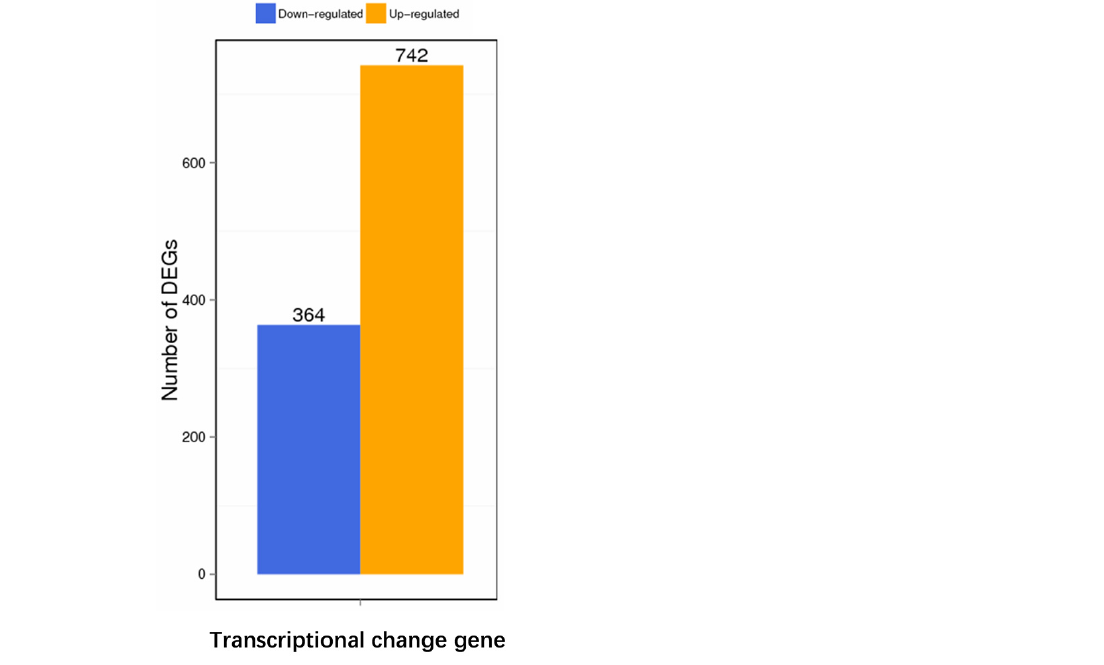
Figure 2. Differential genes expression. Compared with the wild-type strain, there were 742 up- regulated genes and 364 down-regulated genes after pfs deletion.